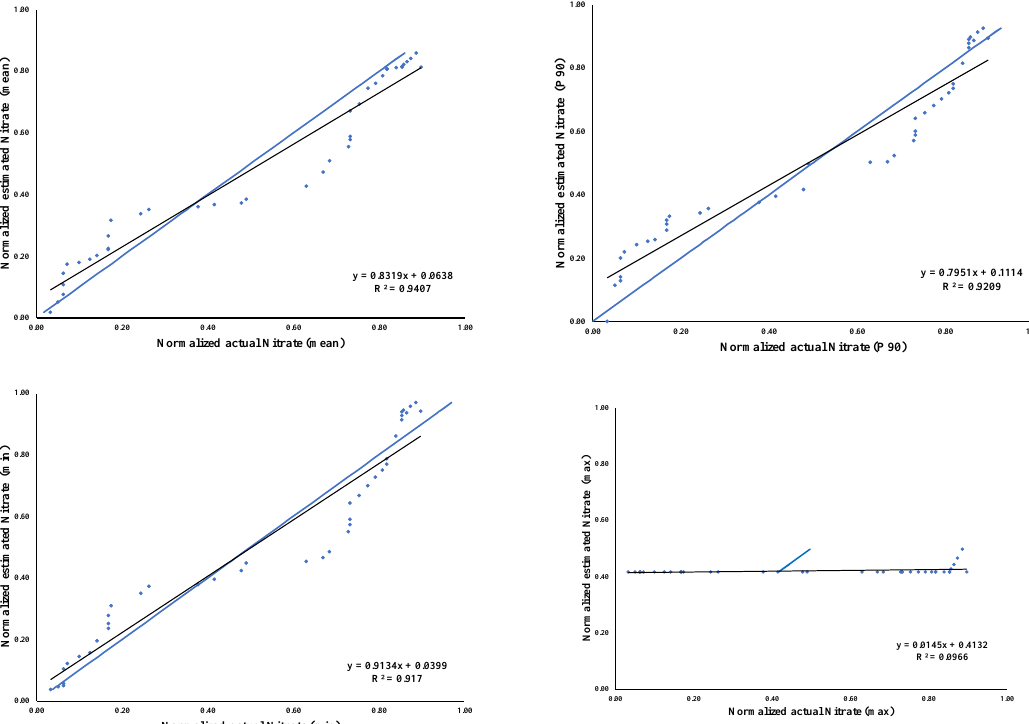
Figure 3. Green normalized difference vegetation index (GNDVI) regression analysis with respect to different zonal statistics